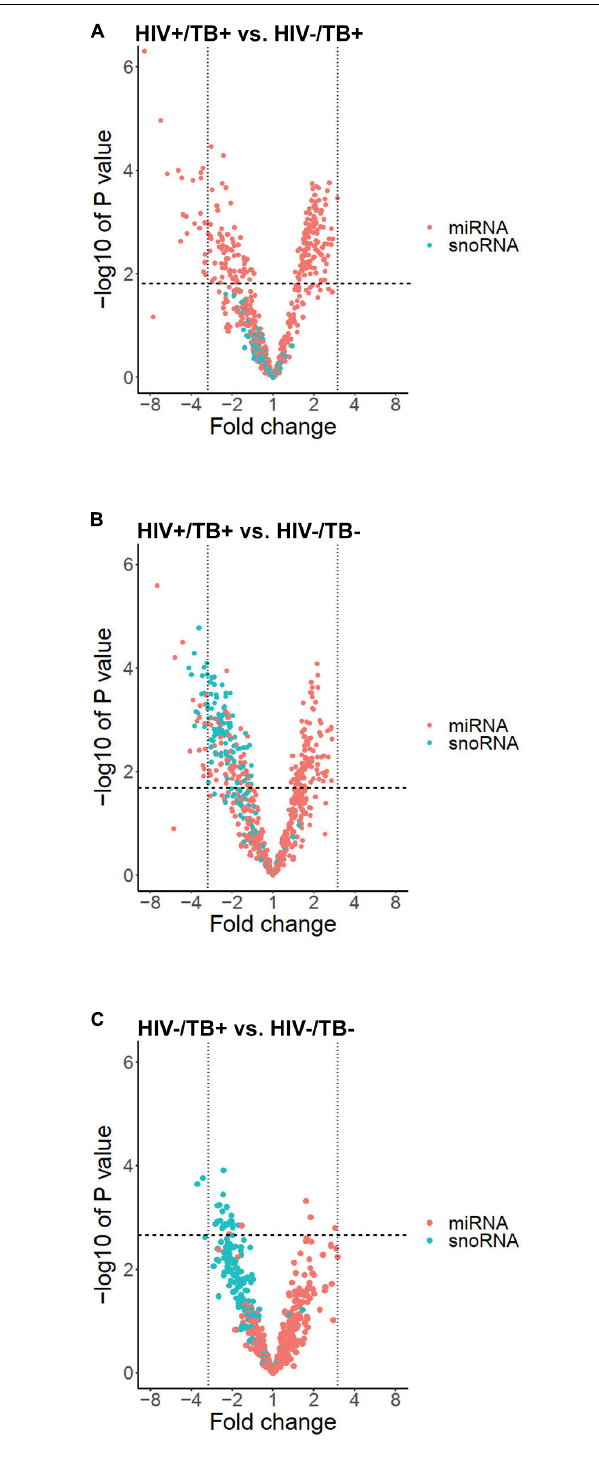
FIGURE 2 | Volcano plots illustrating expression profiles of miRNAs (red dots) and snoRNAs (blue dots) according to fold change on a logarithmic scale (x-axis) and -log of P -value (y-axis) in the groups (A) HIV+/TB+ vs. HIV-/TB+, (B) HIV+/TB+ vs. HIV-/ TB-, and (C) HIV-/TB- and HIV-/TB+. Vertical black lines indicate a fold change of three. Horizontal line indicates largest P -value generating FDR < 0.05.